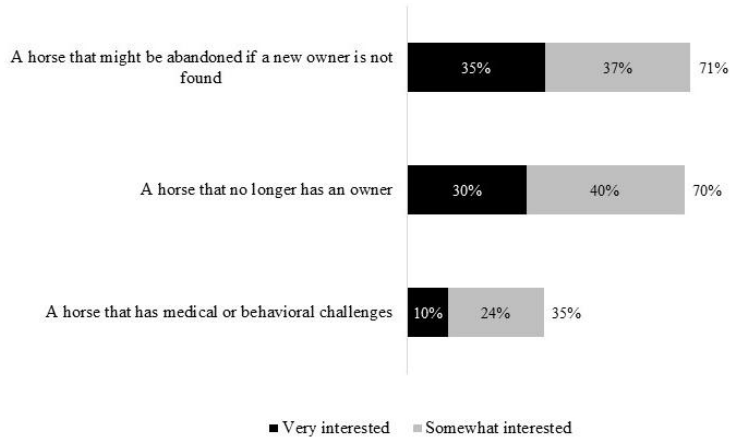
Figure 1. Proportion of respondents in each category.